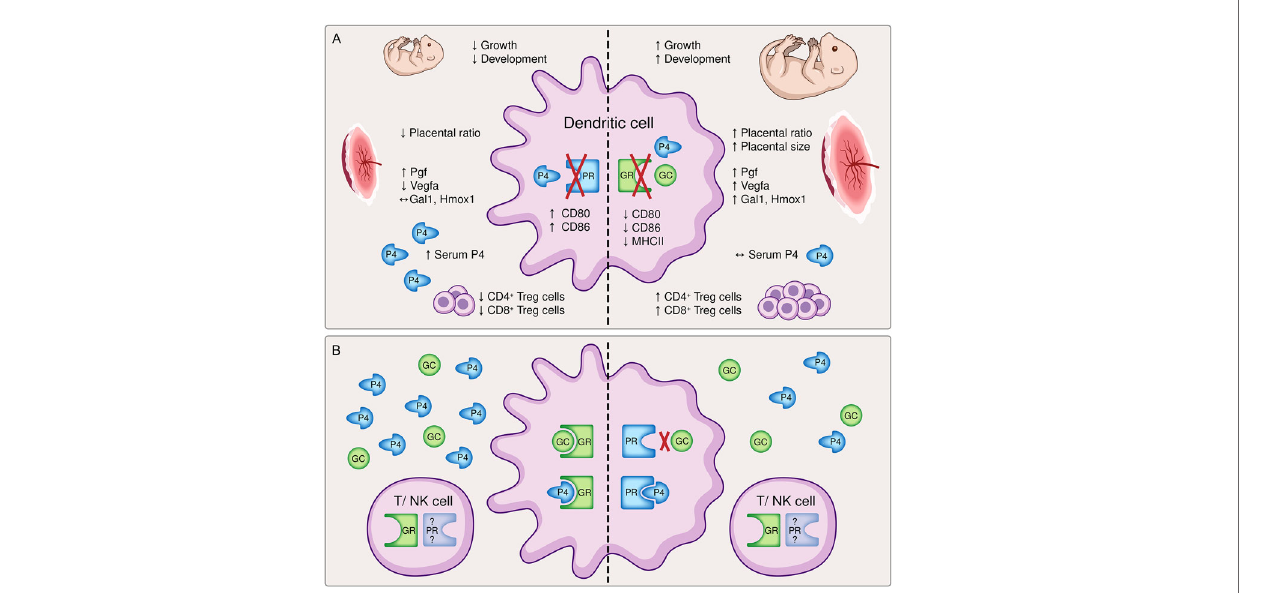
FIGURE 6 | A graphical summary comparing (A) the effects of a dendritic cell (DC)-speci fi c knockout of the progesterone receptor (PR, left) and the glucocorticoid receptor (GR, right) and (B) potential compensatory pathways available to the immune system. (A) The inability to respond to either progesterone (P4) or glucocorticoids (GC) resulted in opposite effects regarding fetal growth and development, placental histomorphology and function, the immune cell phenotype of DCs and the generation of pregnancy-protective CD4 + and CD8 + regulatory T cells, respectively. Left: The conditional knockout of the PR on DCs led to a signi fi cantly reduced fetal weight and histomorphological and functional impairment of the placenta. Immune adaptational processes were negatively affected as observed by an increased frequency of co-stimulatory molecules CD80/86 on CD11c + DCs along with reduced frequencies of CD4 + FoxP3 + and CD8 + CD122 + regulatory T (Treg) cells, although serum progesterone concentrations were elevated (6) Right: In contrast, the conditional knockout of the GR on DCs improved fetal growth and placenta function. An augmented tolerant immune microenvironment was demonstrated by decreased expression of co-stimulatory molecules major histocompatibility complex (MHC) II and CD80/86 on CD11c + dendritic cells and increased frequencies of CD4 + and CD8 + Treg cells despite similar serum progesterone levels. (B) The inability of progesterone or glucocorticoids to exert their function via the preferred receptor may foster the utilization of compensatory pathways. Left: A dysfunctional PR can be partly compensated by progesterone and glucocorticoids acting via the GR. Right: The binding af fi nity of glucocorticoids to the PR is rather low, but a disrupted GR may be counterbalanced by progesterone binding to the PR. Additionally, hormonal signaling directly via T cells and natural killer (NK) cells may be feasible, although the expression of the PR on T cells and NK cells is still debatable. Pgf, placental growth factor; Vegfa, vascular endothelial growth factor A; Gal1, galectin-1; Hmox1, heme oxygenase